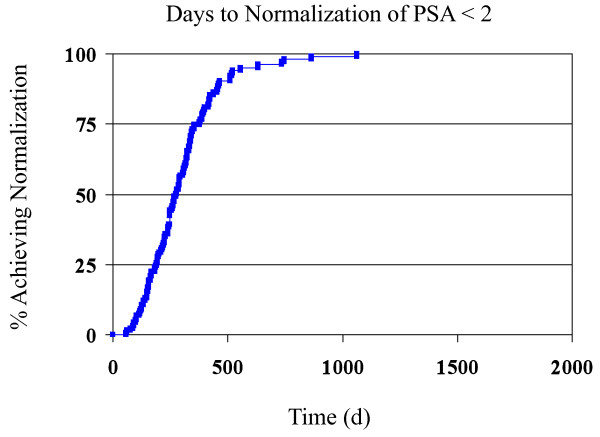
Kaplan-Meier curve detailing the time for normalization of PSA to less than 2 ng/ml.